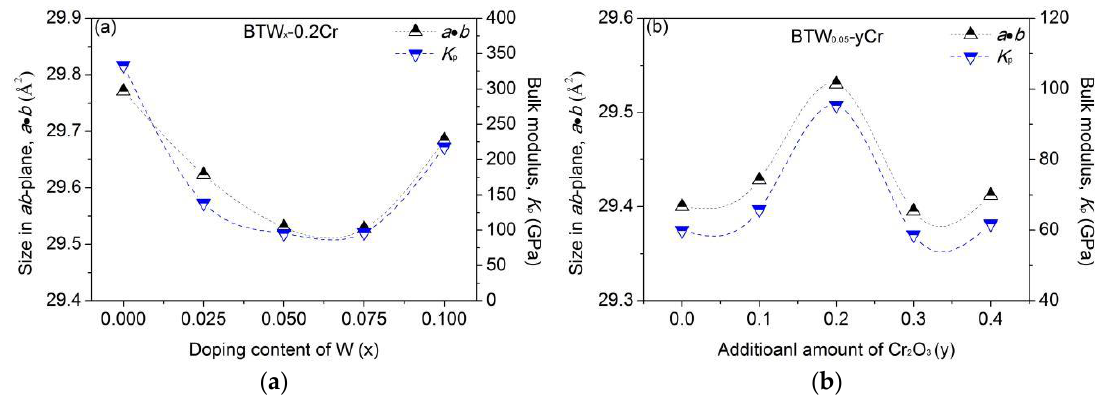
Figure 8. Variation of the size in ab- plane and the bulk modulus of perovskite unit of BTWC with the composition ( a ) varying with the doping content of W ( x ); ( b ) varying with the additional Cr 2 O 3 ( y ).